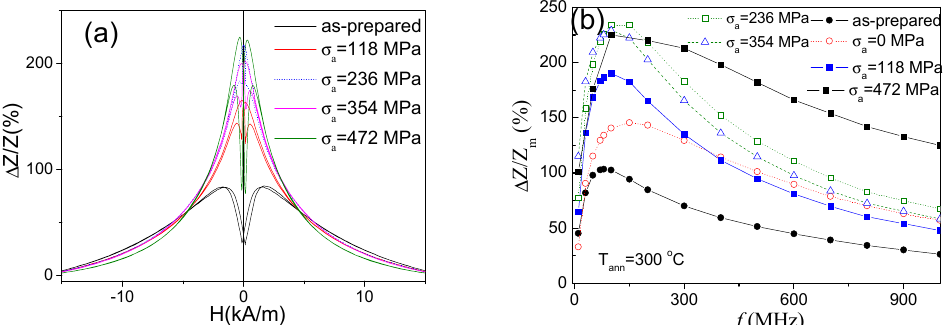
Figure 11. ∆ Z / Z ( H ) dependences of as-prepared and stress-annealed at T ann = 300 ◦ C samples at Figure 11. Δ Z/Z ( H ) dependences of as-prepared and stress-annealed at T ann = 300 °C samples at di ff erent σ a measured at 200 MHz ( a ) and ∆ Z / Z m ( f ) dependencies for the same samples ( b ). different σ a measured at 200 MHz ( a ) and Δ Z/Z m ( f ) dependencies for the Consequently, we can resume that the stress-induced anisotropy allows tuning of both the GMI same samples ( b ). ratio value and the ∆ Z / Z m ( f )